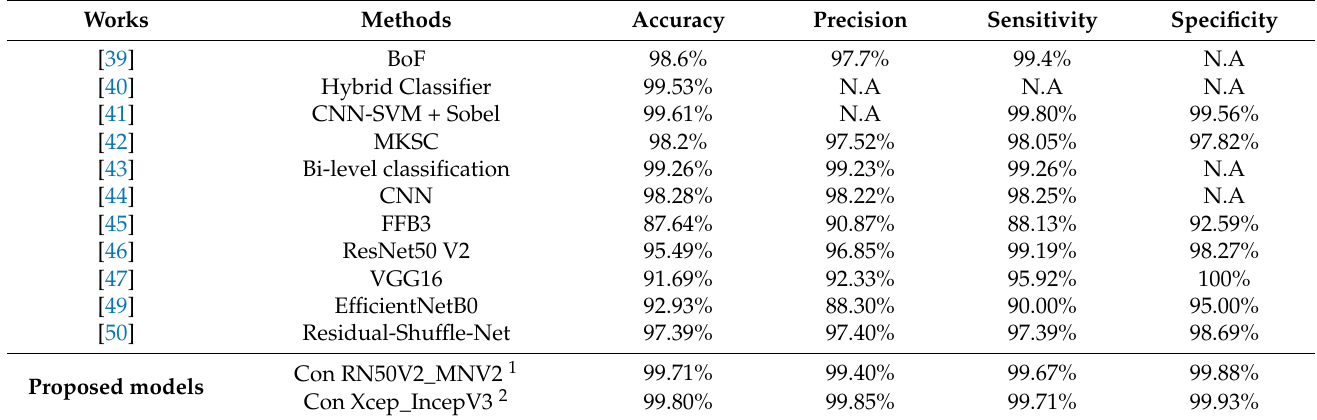
Table 16. Comparative results for the obtained model with previous research in the